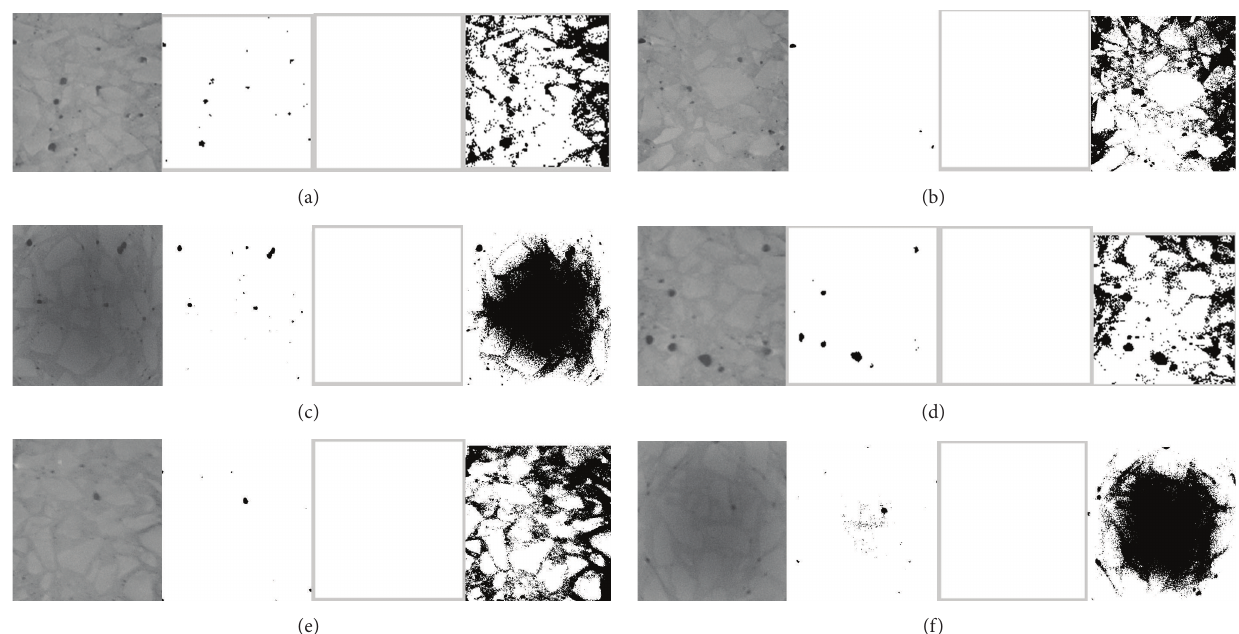
Figure 2: Comparison of segmentation results for CT concrete images by three threshold methods. (a)–(c) denote the original C30 CT images. (d)–(f) denote the original C40 CT images. From left to right column: results of original CT images, two-mode algorithm, iterative algorithm, and Otsu